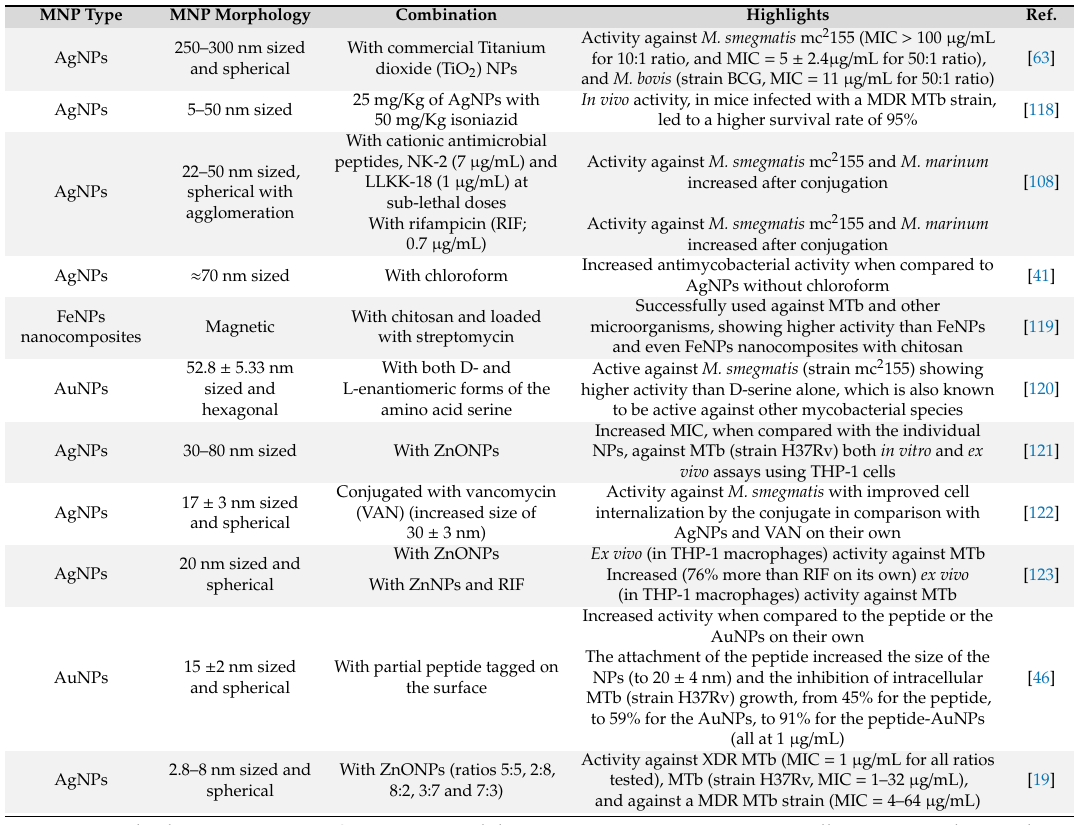
Table 6. Antimycobacterial activity complemented or increased by